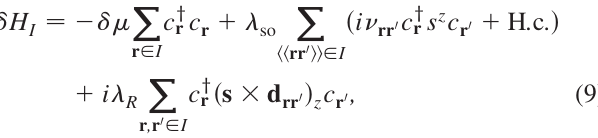
FIG. 3. Coverage effects. Spin-orbit-induced gap (cid:1) opened at the Dirac points and Fermi level E sured relative to the center of the gap for different indium and thallium adatom coverages. The open and filled symbols repre- sent data for indium and thallium,